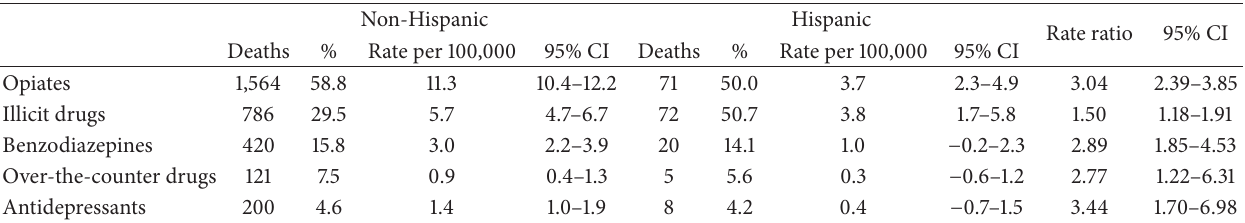
Table 2: Specific drug types implicated in death according to ethnicity in Utah,